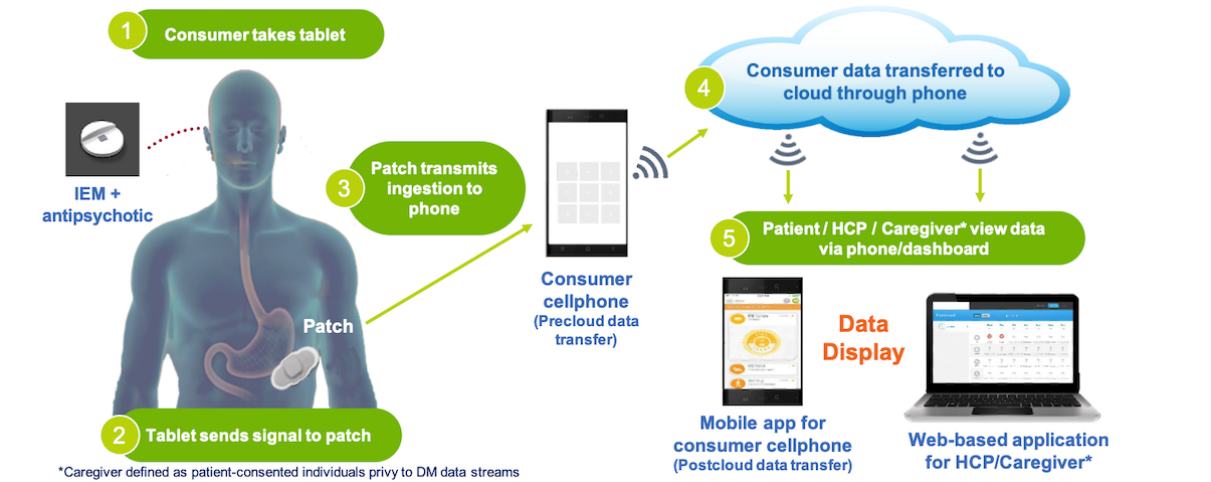
Figure 1. Schematic of the DMS. The DMS consists of an ingestible sensor embedded within an aripiprazole tablet. Upon ingestion, this sensor communicates with a patient-worn patch, which records the ingestion event and provides measures of activity and heart rate using an accelerometer and ECG, respectively, as well as temperature and impedance across the patch. The patch then communicates all data to a smartphone app, which stores the data on a secure cloud server that can be accessed by patients or designated caregivers via a mobile or web-based dashboard. DM: digital medicine; DMS: digital medicine system; ECG: electrocardiogram; HCP: health care provider; IEM: ingestible event